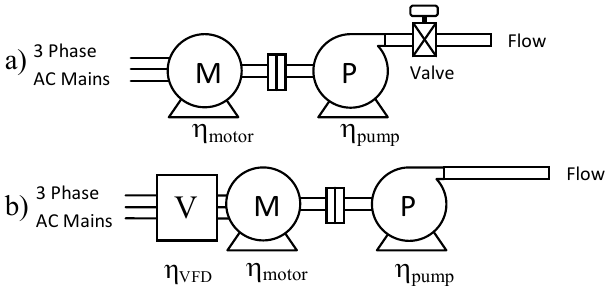
Figure 1. Simplified representation of pump systems: (a) fixed speed pumps and (b) variable speed pumps. M: motor, P: pump, V: Variable frequency drive, η : e ffi ciency.